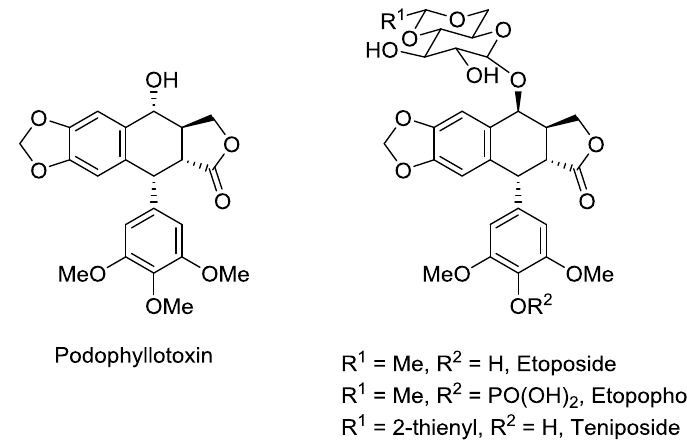
Figure 2. Structure of podophyllotoxin and three of its most notable derivatives; etoposide, etopophos and teniposide.